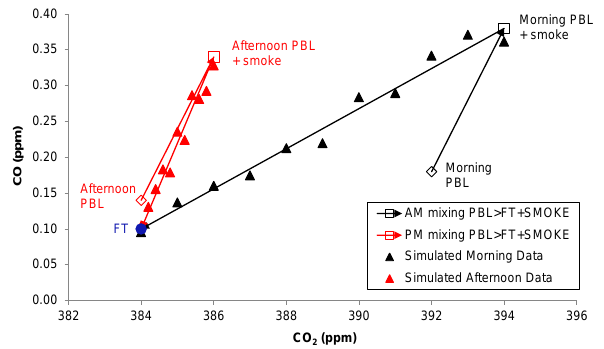
Fig. 1. A scenario encountered in the Amazon described in Andreae et al. (2012). The morning PBL has mixing ratios of 392 ppm CO 2 and 0.18 ppm CO (shown by the black diamond). A fire burning in the morning hours with a Δ CO/ Δ CO 2 ER of 0.1 adds 2 ppm Δ CO 2 and 0.2 ppm Δ CO to the morning PBL, creating a plume with the composition indicated by the black square (394 ppm CO 2 , 0.38 ppm CO). This plume is lofted into the free troposphere, which has the composition indicated by the blue circle (384 ppm CO 2 , 0.1 ppm CO), and mixes with this FT air. The black triangles simulate the data that would be obtained (with 10% “noise” added) as an aircraft flies through this plume acquiring “real time” data as the plume dilutes. From the FT aircraft data, an erroneous ER of 0.03, instead of the correct value of 0.1, would be calculated as a result of the error introduced by multiple mixing with different air masses. In the afternoon, the gradient between the PBL (red diamond, 384 ppm CO 2 and 0.14 ppm CO) and the FT is reduced. Adding the same amount of smoke, with the same composition as from the morning fire, now creates a plume with the composition indicated by the red square (386 ppm CO 2 , 0.34 ppm CO). When the afternoon plume is lofted into the FT, which has the same composition as in the morning, the research aircraft would obtain data simulated by the red triangles. An ER of 0.12 would be calculated from these data, much closer to the true value of 0.1.